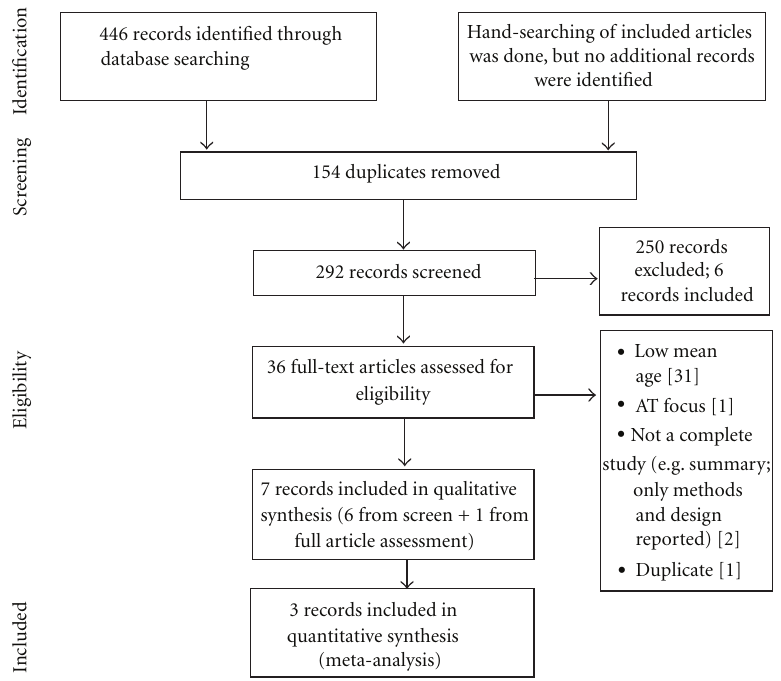
Figure 2: Study selection diagram [50] AT-aerobic